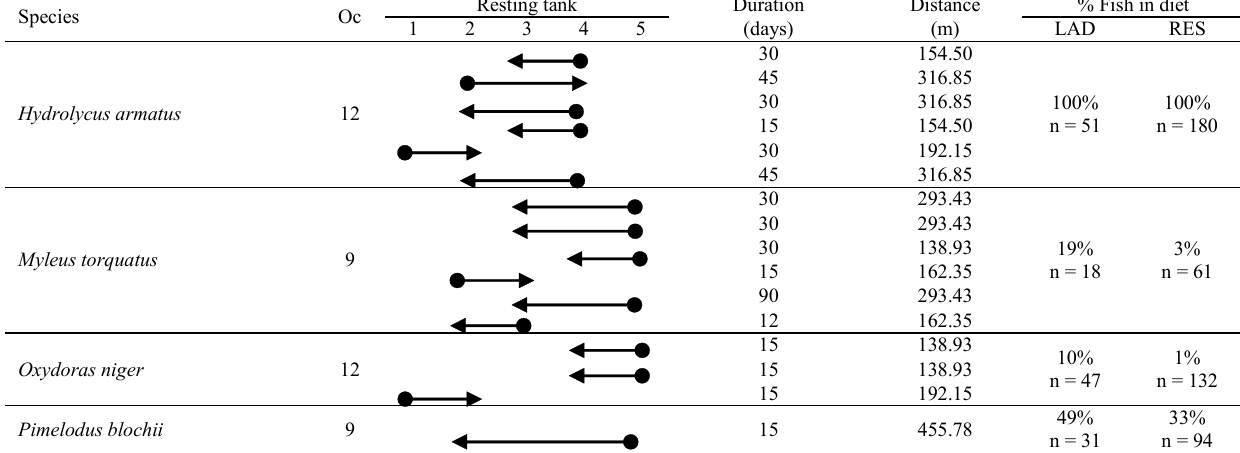
Table 2. Capture and mark-recapture data for the Lajeado Dam fish ladder, showing the species with longer release-recapture times, including the time, distance between tanks and proportion of fish in the diets of individuals from the ladder (LAD) and reservoir (RES). Oc = number of months occurrence in the ladder between November 2002 to October 2003, (n) = number of stomachs analysed, Arrows indicate displacements and